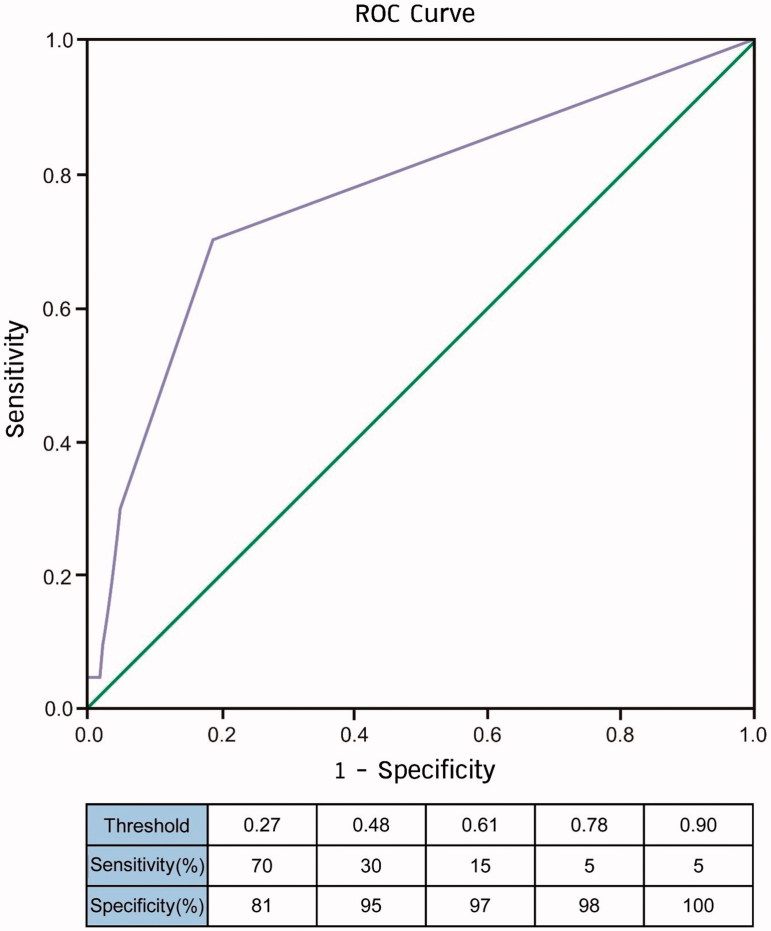
The ROC of the predictive accuracy of an ionized magnesium fraction-based equation model for preeclampsia: the ionized magnesium fraction-based equation model was derived from the logistic regression analysis on the fraction, teenage as well as elderly primigravida. The area under ROC curve was 0.77, indicating a significant degree of discrimination (p < .001). Scores of >0.27 were highly suggestive of preeclampsia with 70% sensitivity and 81% specificity.